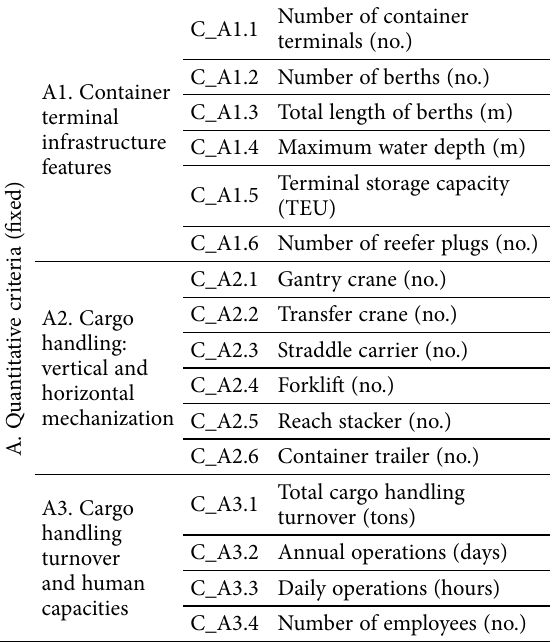
Table 1. Quantitative